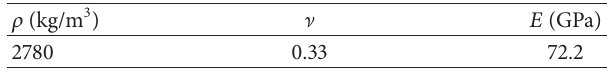
Table 1: Mechanical properties of aluminum